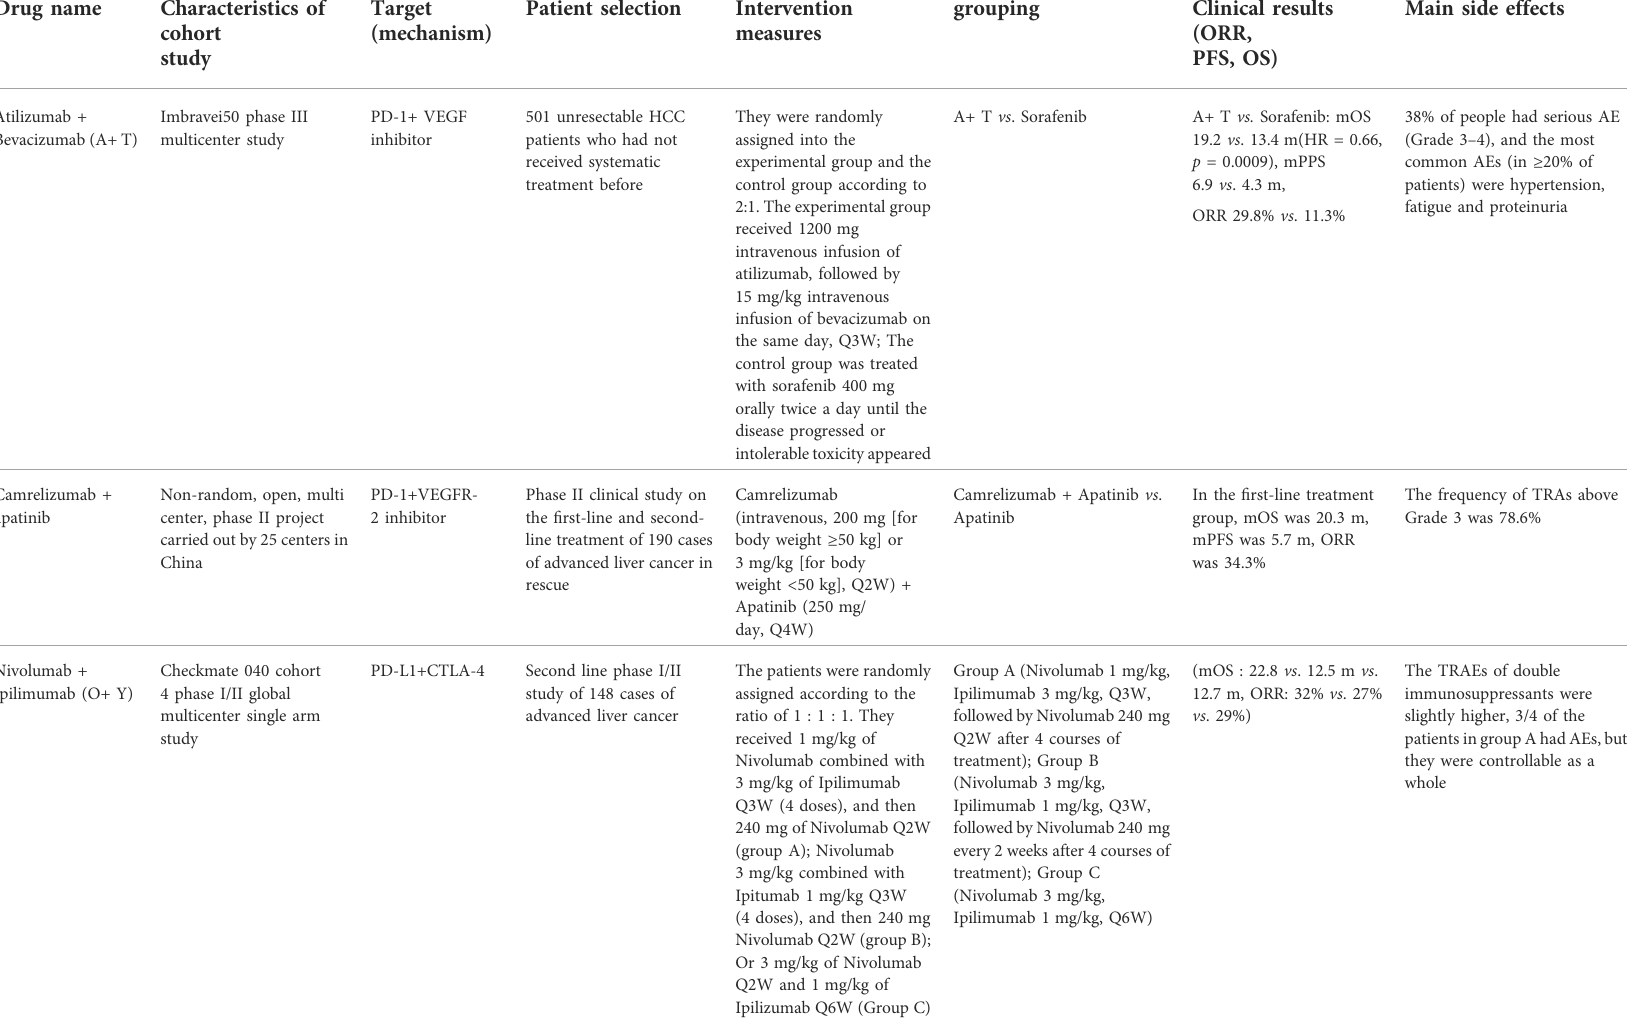
TABLE 1 Progress of various immune checkpoint inhibitors in the treatment of primary liver